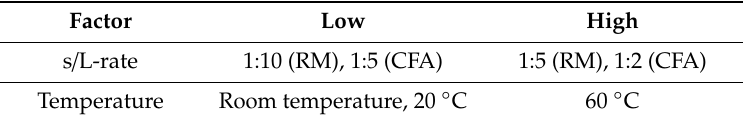
Table 6. Design of the experiment.